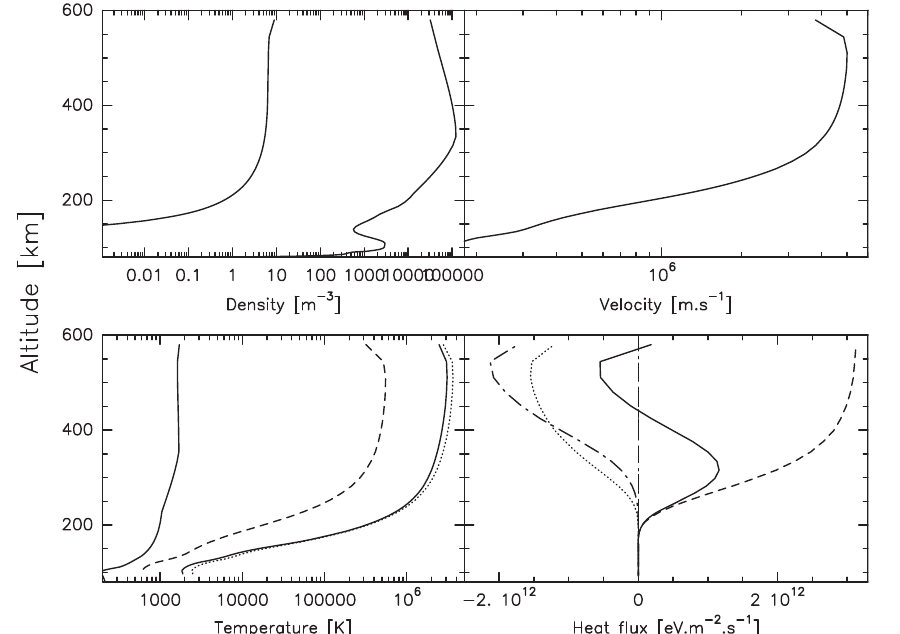
Fig. 9. Suprathermal moments in the auroral oval during nighttime. Upper left panel: from left to right, suprathermal electron density computed in this work, compared to the thermal one provided by IRI (Bilitza et al., 2012). Right panel: suprathermal velocity. Lower left pannel: from left to right, thermal electron temperature provided by IRI, suprathermal electron temperature (dashed line: mean temperature; full line: speci fi c temperature; dotted line: total suprathermal electron temperature). Right panel: suprathermal heat fl ux. With respect to equation (13), we have from left to right: v 2 ( z ) in dotted line, v 5 ( z ) in dot-dashed line, full line v ( z ), along the 0 abscissa are v 3 ( z ) and v 4 ( z ) which are negligible at this scale compared to the other quantities, and fi nally on the right side is v 1 ( z ) in dashed line. The velocity and the heat fl uxes are positive